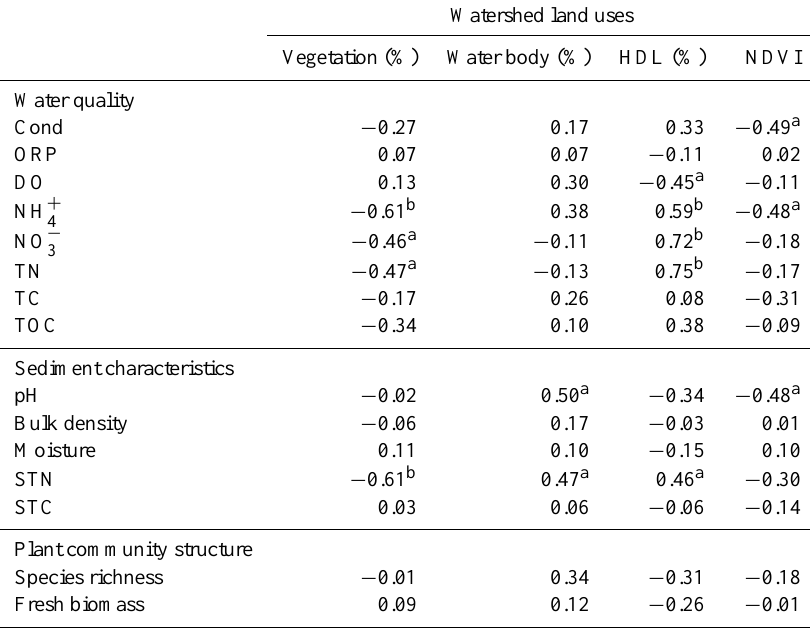
Table 2. Pearson correlation coefficients between watershed land uses and within-lake characteristics ( N = 20).